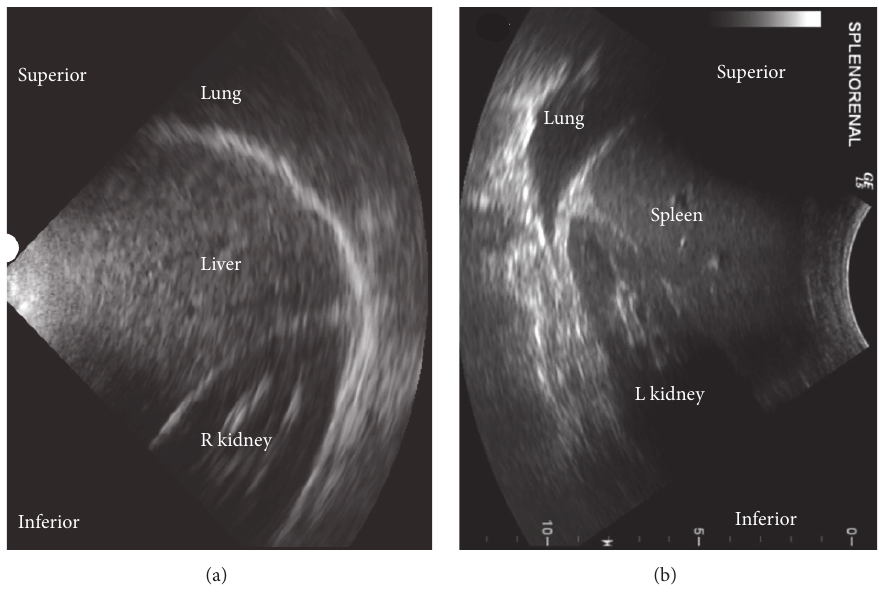
Figure 6: Renal assessment: ultrasound landmarks for kidneys. (a) RUQ hepatorenal view: landmarks for locating the kidney in the lateral right upper quadrant using a phased-array probe. The echogenic line separating the lung from the liver is the diaphragm (see Figure 4, probe position B). Adapted from Perera et al. with the authors’ permission [27]. (b) LUQ splenorenal view: landmarks for locating the kidney in the lateral left upper quadrant using a curvilinear probe. The echogenic line separating the lung from the spleen is the diaphragm (see Figure 4, probe position C). Adapted from Montoya et al. with the authors’ permission